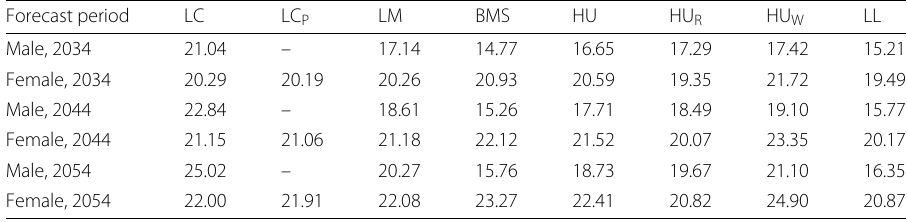
Table 9 Forecast of remaining life expectancies at age 65 for Hungarian males and females Forecast period